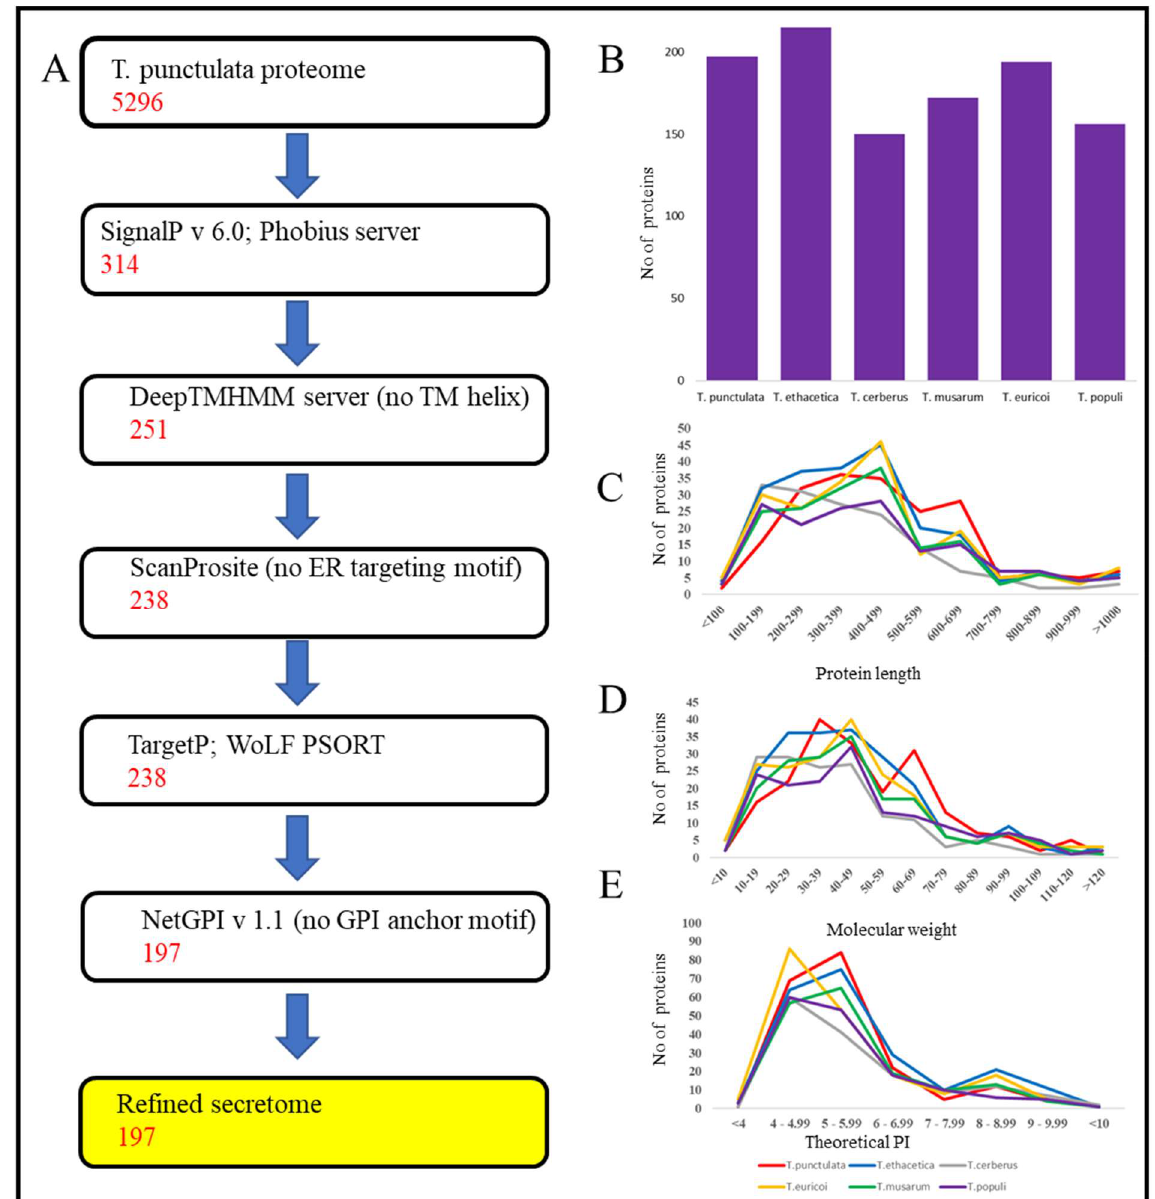
Figure 2. Secretome prediction in Thielaviopsis punctulata and its closely related species. ( A ) Pipeline for the prediction of secretome. The number of proteins in each step is given for T. punctulata . ( B ) Number of secretome of all six species analyzed. ( C ) Length distribution of the secretome. ( D ) Molecular weight of the secretome. ( E ) Theoretical PI of the secretome.